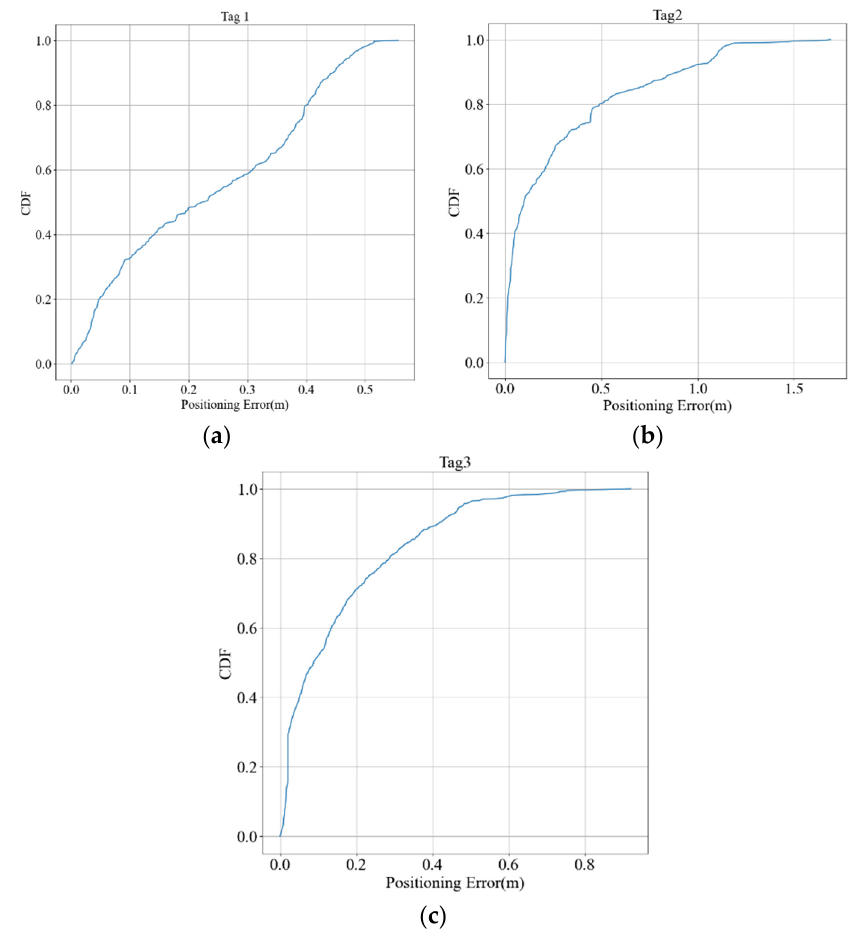
Figure 26. Positioning error CDF of ( a ) tag 1, ( b ) tag 2, ( c ) tag 3.